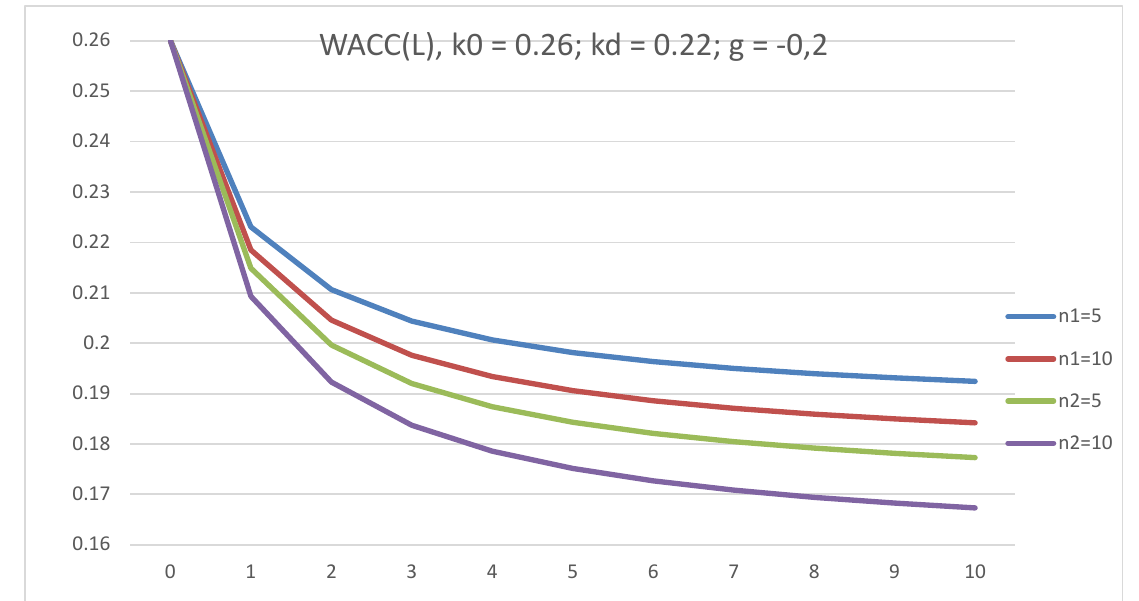
Figure 10. The dependence of WACC on leverage level, L, in GBFO theory with payments of tax on profit at the end of periods (1) and advance payments (2) at k 0 = 0.26; k d = 0.22; t = 0.2; g = − 0.2, for five-year and ten-year companies.